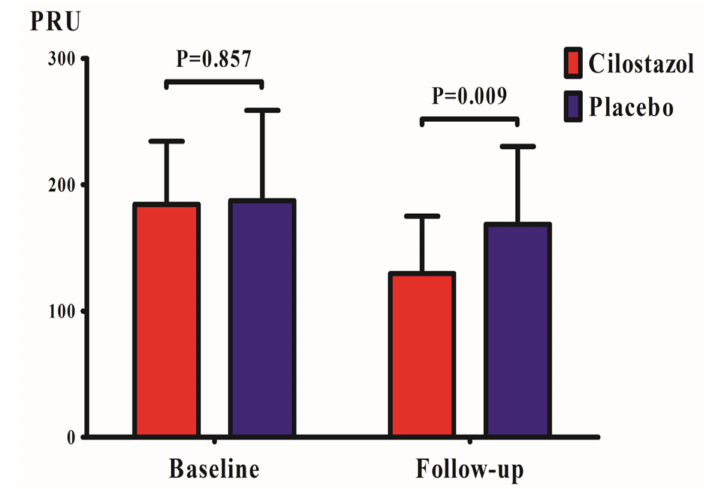
Figure 5. Changes of platelet reactivity. Adjunctive cilostazol on top of dual antiplatelet therapy showed a lower level of platelet reactivity compared with placebo. PRU = P2Y12 Reaction